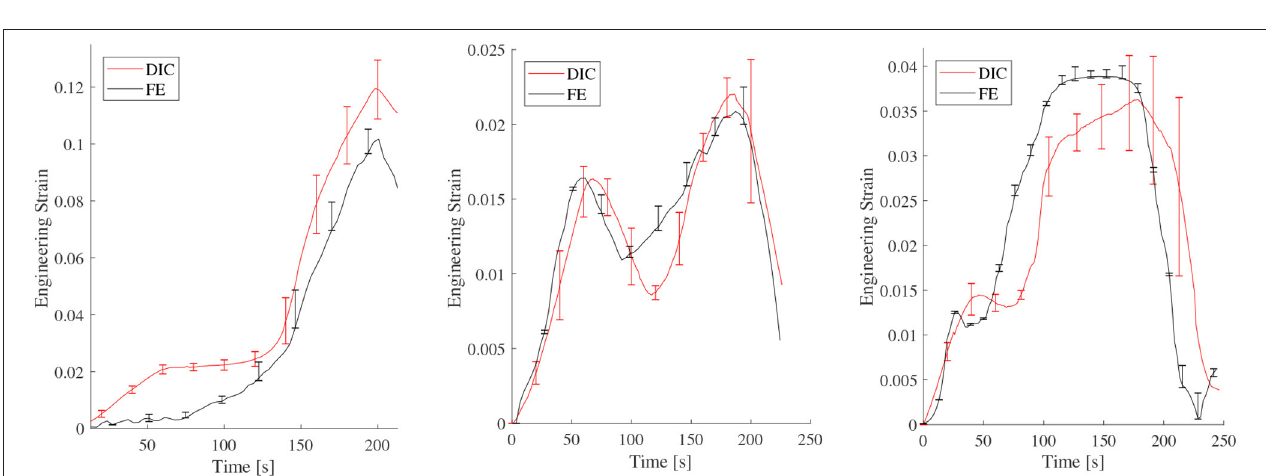
FIGURE 10 | DIC vs FE engineering strain on struts belonging to the central cell, for (Left) re-entrant topology (axial strut), (Middle) re-entrant topology (diagonal strut), and (Right) tri-chiral topology (single strut).